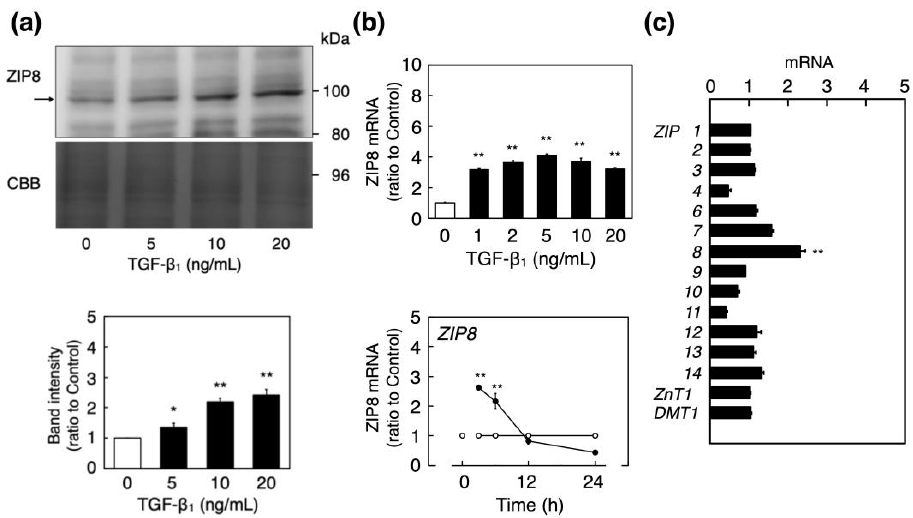
Figure 2. ZIP8 induction in vascular endothelial cells following treatment with TGF- β 1 . ( a ) Bovine aortic endothelial cells were treated with or without TGF- β 1 (5, 10, or 20 ng/mL) for 24 h, and the